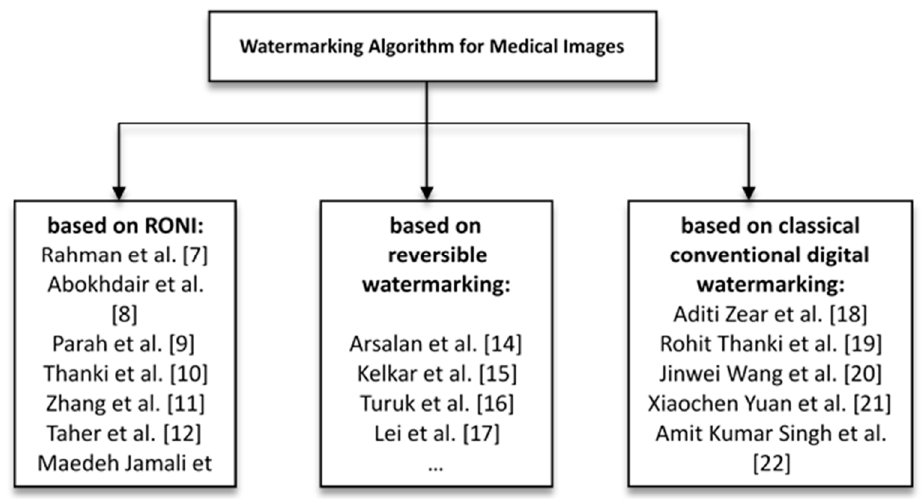
Figure 1. Category of watermarking algorithms for medical images.